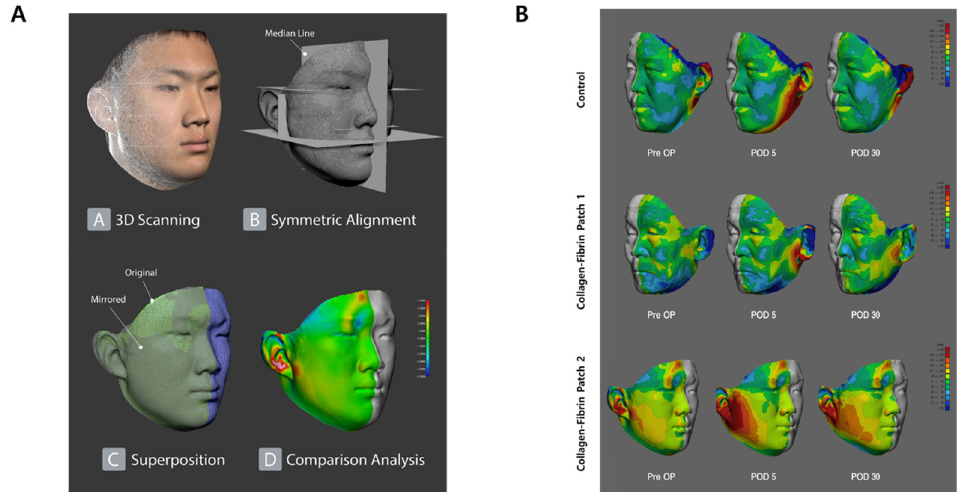
Figure 6. Three-dimensional (3D) surface evaluation of facial asymmetry before and after surgery. ( A ) 3D data production and processing workflow using stereophotogrammetry. ( B ) Histogram of pre- and post-operative facial asymmetry. In the control group, the difference in facial asymmetry was a negative value at 30 days postoperatively, whereas the values in fibrinogen-thrombin-collagen sponge patch group were positive in both representative patients. The color ranges visualized on the surgical site depict the range of changes of asymmetry after surgery in millimeters.